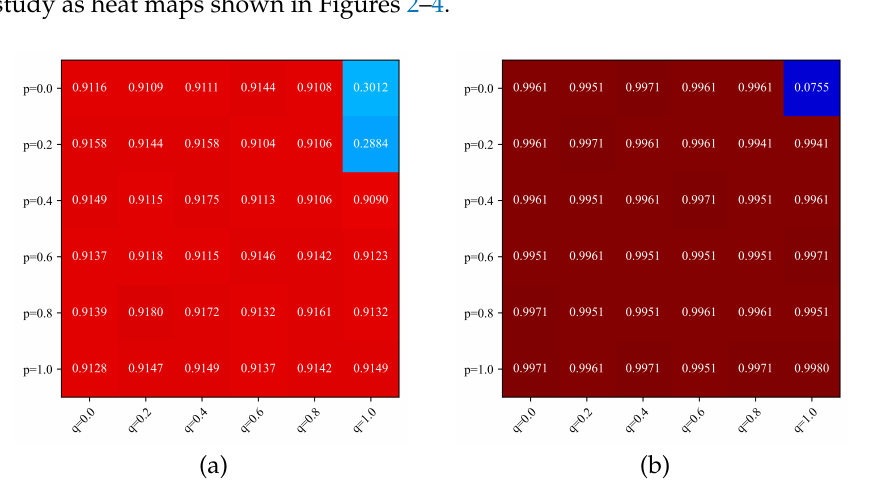
Figure 2. Heat map of model accuracy for different values of p and q . ( a ) Birds. ( b ) Flowers.